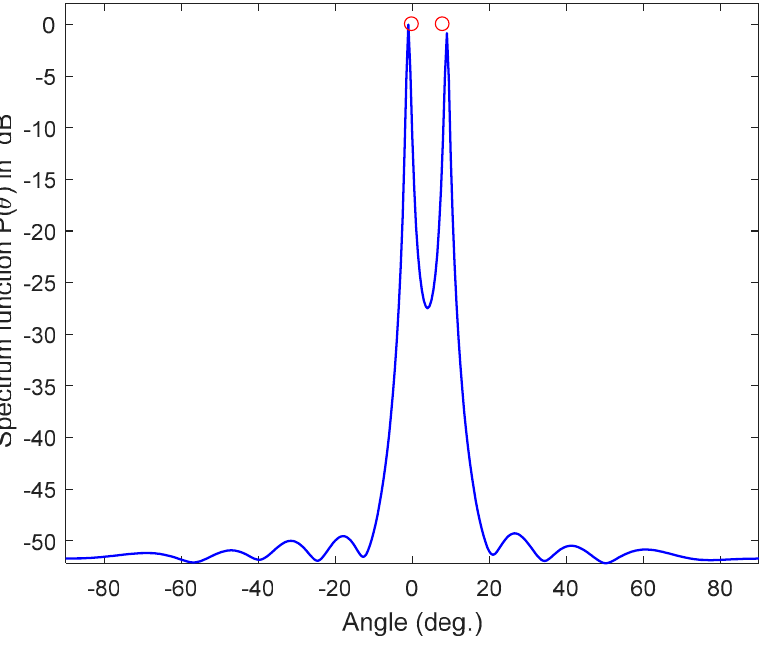
Figure 3. Performance estimation of the PDDA method, M = 10, SNR = 10 dB, N = 10, D = 2.